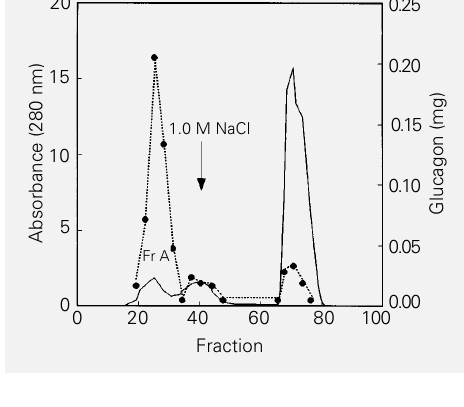
Figure 1 - Ion-exchange chro- matography of glucagon on Q- Sepharose FF. The isoelectric precipitate (400 mg/ml eluent) was applied to a 2.0 x 26-cm column and eluted at room temperature with 50 mM Tris- HCl, 7 M urea, pH 9.0, at a flow rate of 5.0 ml/min. Frac- tions of 5.0 ml were collected and the amount of glucagon was determined by RIA. The arrow indicates the fraction where the buffer NaCl con- centration was increased to 1.0 M NaCl. Absorbance at 280 nm (solid line), mg gluca- gon (dashed line). Figure 3 - Ion-exchange chro- matography of glucagon on S- Sepharose FF. The sample, 100 mg of fraction B (Fr B) from Sephadex G-25 (Figure 2), was applied to a 1.6 x 10- cm column and eluted at room temperature with 50 mM so- dium citrate, 7 M urea, pH 4.0, at a flow rate of 2.5 ml/min. Fractions of 3.0 ml were col- lected and the amount of glu- cagon was determined by HPLC. The arrows indicate the fractions where the buffer NaCl concentration was in- creased by the addition of NaCl. Absorbance at 280 nm (solid line), mg glucagon (dashed line).